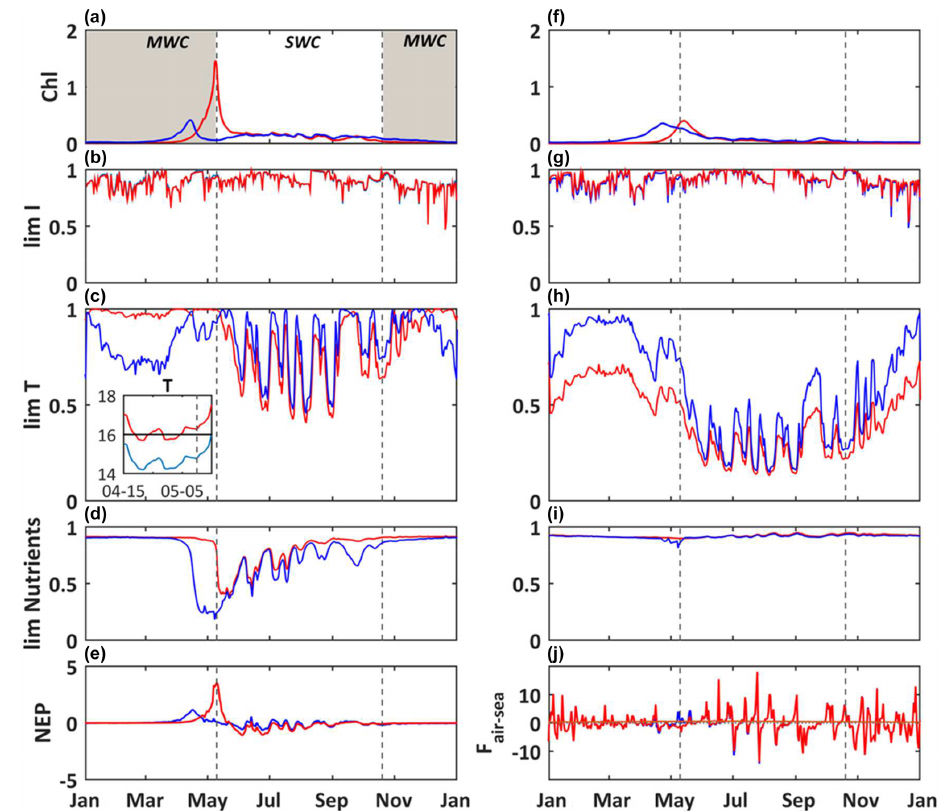
Figure 5. Modeled daily average chlorophyll a concentrations (mgm − 3 ) (a) , light limitation (b) , temperature limitation, and a close-up from 15 April to 5 May of temperature (c) and nutrient limitation (d) for picophytoplankton and the same set for diatoms (f–i) . Modeled daily average NEP (mmolm − 3 d − 1 , e ) and air–sea CO 2 fluxes (mmolm − 3 d − 1 , j ). Reference simulation ( S 0, blue line) and temperature-shifted simulation by 1.5 ◦ C ( S 2, red line). The shaded area and dotted black lines delimit the SWC and MWC